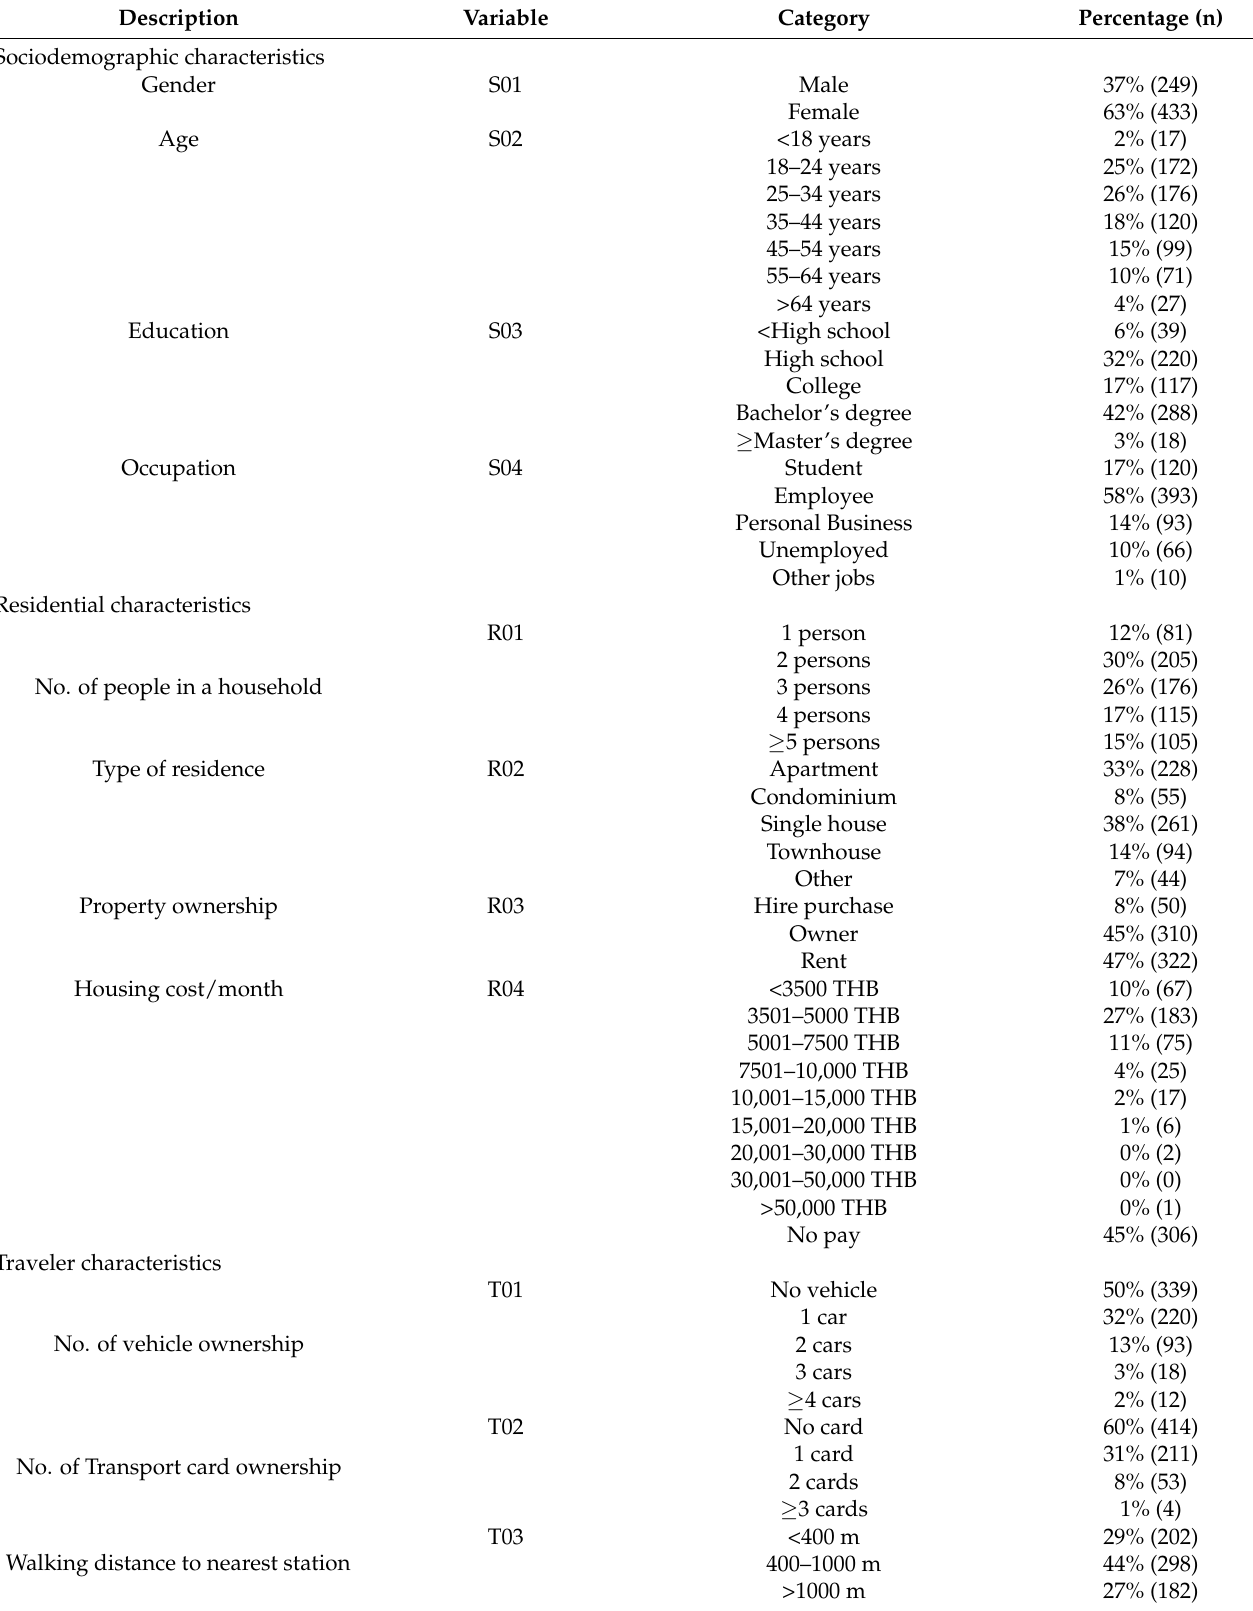
Table 1. Characteristics of